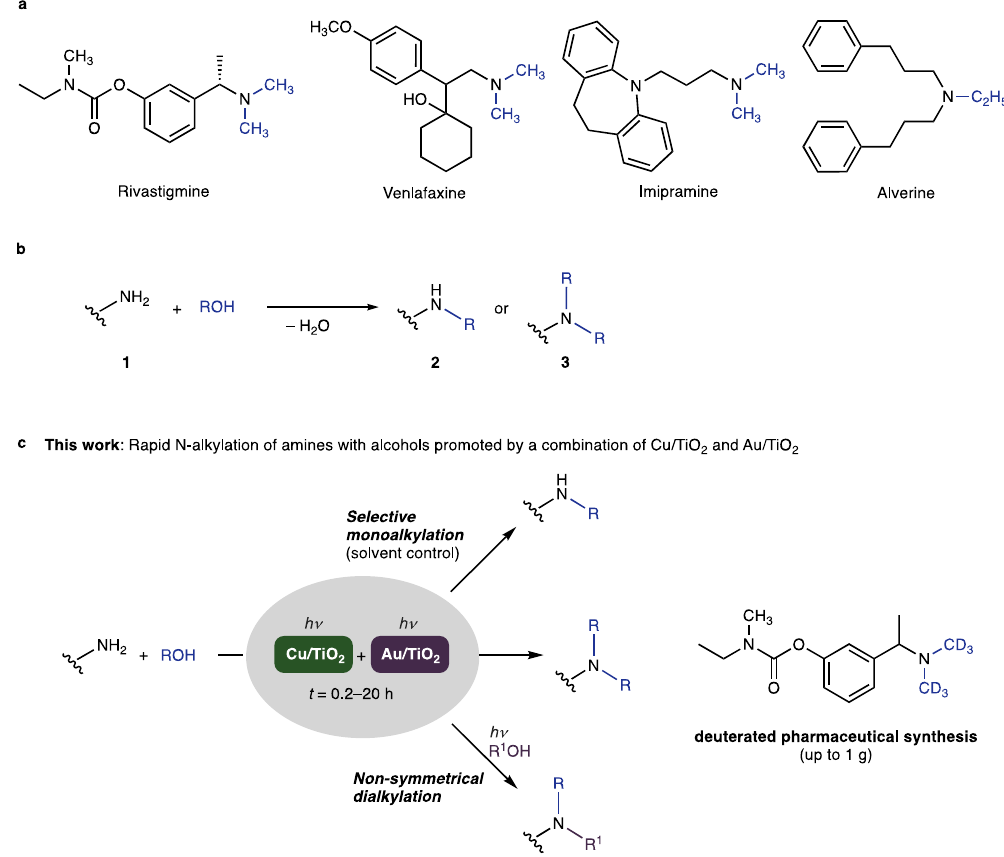
Figure 1. A mixture of two photocatalysts enables rapid N-alkylation of amines with alcohols under light irradiation. ( a ) Representative pharmaceuticals with N-alkylated groups: Rivastigmine (dementia), Venlafaxine (depression), Imipramine (depression), Alverine (gastropathy). ( b ) General scheme of N-alkylation of amines employing alcohols as alkylation reagents. ( c ) Outline of this